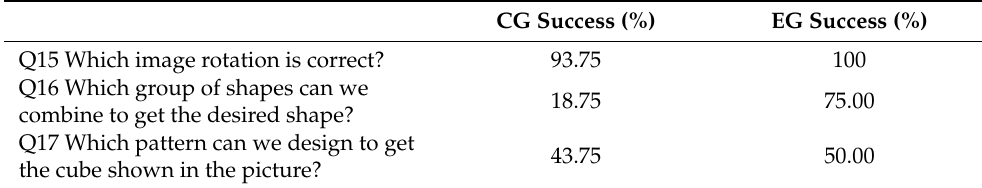
Table 4. Students spatial orientation—Smith and Whetton questionnaire